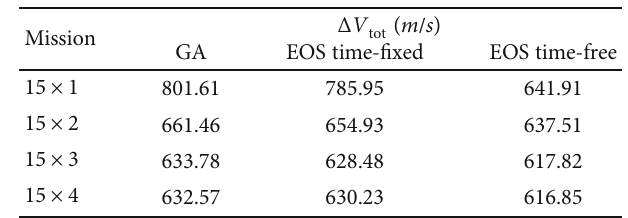
Table 3: Attained solutions at successive stages of the optimization process. GA refers to the solutions of the outer-level problem; EOS time- fi xed and EOS time-free refer to the re fi ned solutions at the end of the inner-level optimization, by assuming the rendezvous epochs fi xed or free to be optimized,